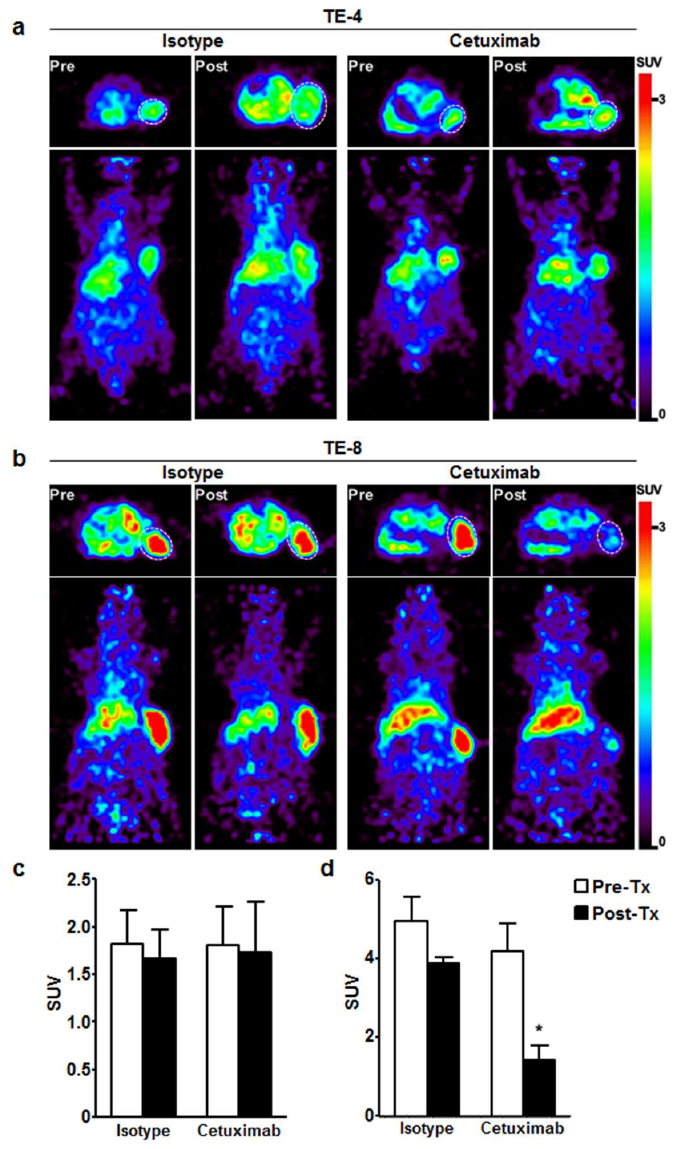
Figure 5. Immuno-PET imaging of EGFR expression level in ESCC xenograft model before and after cetuximab treatment. Transaxial ( Top ) and coronal ( bottom ) PET images of 64 Cu-labeled cetuximab in ( a ) TE-4 and ( b ) TE-8 tumors determined EGFR level by cetuximab treatment. ( a , c ) 64 Cu-labeled cetuximab uptake was not changed in TE-4 model with isotype or cetuximab treatment. ( b , d ) In TE-8 model, 64 Cu-labeled cetuximab uptake was markedly reduced by only cetuximab treatment. ( c ) and ( d ) Quantitative indices of 64 Cu-labeled cetuximab in TE-4 and TE-8 tumor represented as standardized uptake value (SUV). * p < 0.01. White dotted circle is tumor.